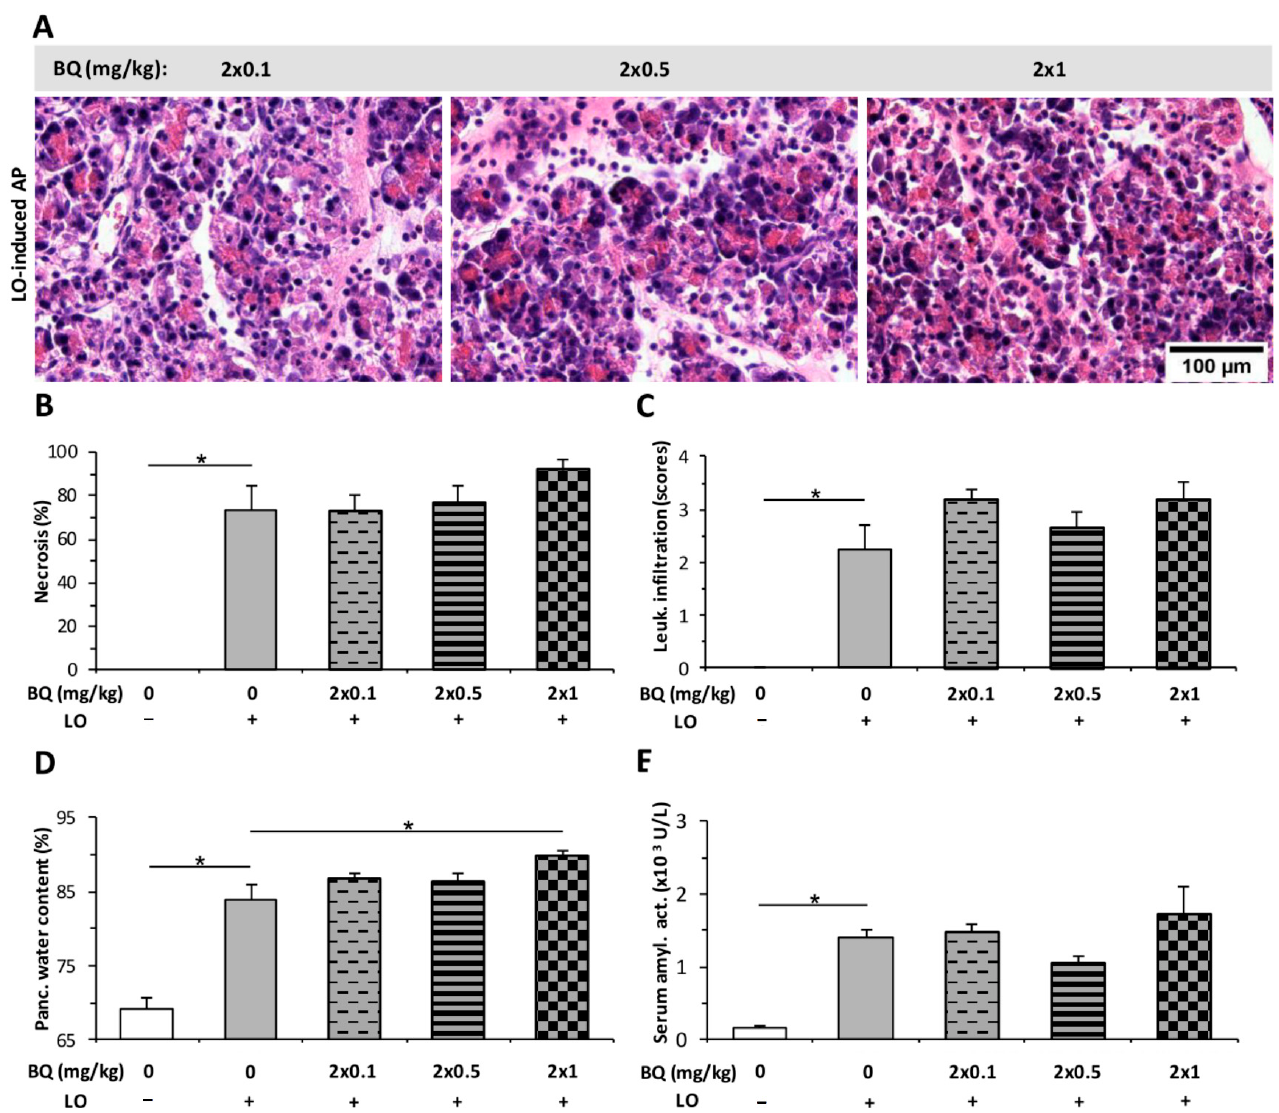
Figure 8. Intraperitoneal (i.p.) buprenorphine (BQ) treatment does not affect the severity of L-ornithine (LO)-induced acute pancreatitis (AP). Rats were treated with 2 × 0.1, 2 × 0.5, or 2 × 1 mg/kg BQ i.p., whereas i.p. injection with 3 g/kg LO (LO +) was used to induce AP. Control animals received physiological saline instead of LO (LO − ) or BQ (0 mg/kg). Animals were sacrificed at 24 h after the first CER or physiological saline injection. ( A ) Representative histopathological images of pancreatic tissues of the treatment groups. Bar charts show the extent of pancreatic ( B ) necrosis, ( C ) leukocyte infiltration, ( D ) water content, and ( E ) serum amylase activity measurements. Values represent mean with standard error, n = 6. Two-way ANOVA was performed followed by the Holm–Sidak post hoc test. * p <